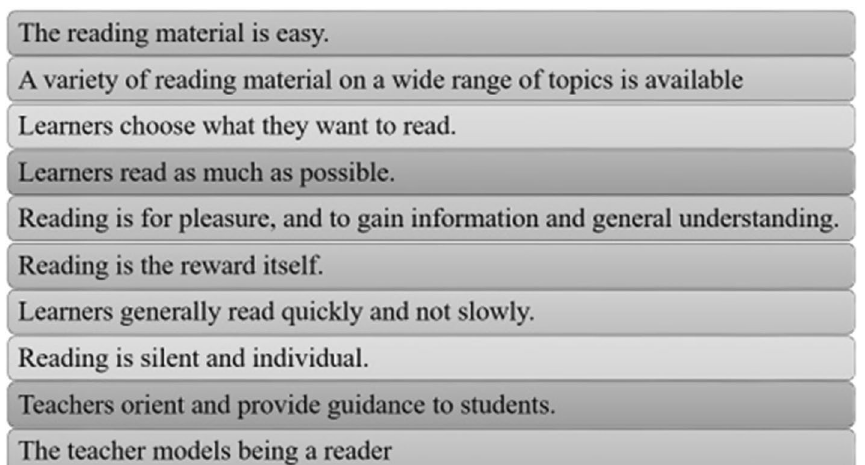
Fig. 1 Top ten principles of ER approach (Adapted from Bamford & Day, 1998, p.